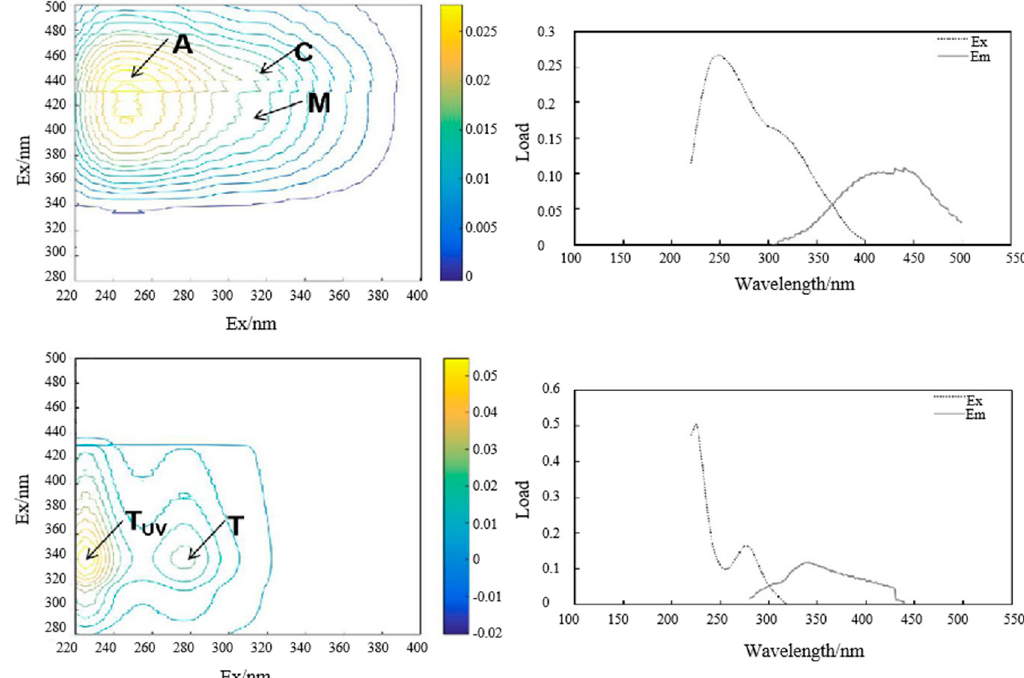
Figure 3. Fluorescent components in the water compartments of Dianchi Lake. On the left: spectral properties of DOM from the two sediments obtained by the parallel factor analysis (PARAFAC). Lines represent the loadings from the two-component model using the whole dataset. A: humic-like component in violet region; C: humic-like component in visible region; M: humic-like component related to microbial origination; T: protein-like component in visible region; Tuv: protein-like component in violet region; Ex: excitation wavelength; Em: emission wavelength; The blue-yellow column represents fluorescent intensity after PARAFAC calculation. Arrows point to the peak of components. On the left: changing load of DOM components along with increasing wavelengths after PARAFAC